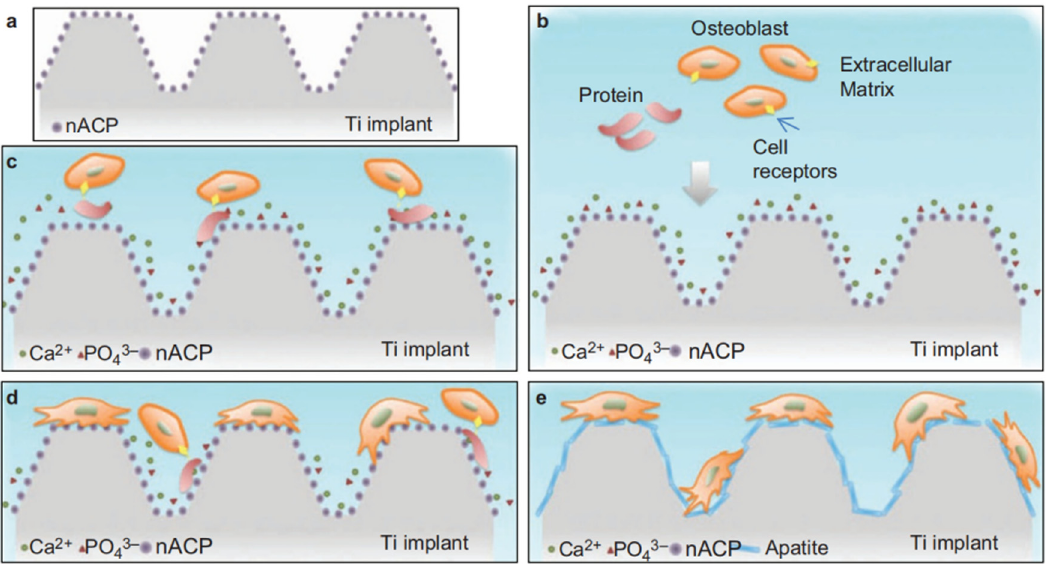
Figure 6: Schematic of biological response of nano - HA - coated titanium implant ( Ti implant ) . ( a ) Ti implant coated with ACP nanoparticles; ( b ) release of Ca 2 + and PO 43 + ions from ACP hydrolysis after implantation; ( c ) cell binding on the implant surface with the help of serum proteins and integrin receptors; ( d ) cell proliferation on the implant surface; ( e ) formation of apatite on the implant surface [ 75 ]